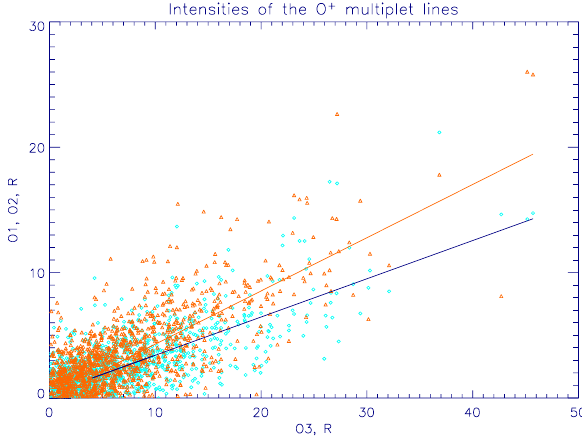
Fig. 7. Plot of I(O + ) vs. N + 1N(0,2) in electron aurora. The bright- 2 nesses are derived as I(O + )=O3/0.357 and I(0,2) = Proxy(0,2)/0.198 . Red triangles – 17 December 2001 points, cyan diamonds – 14 Jan- uary 2002 points. Solid lines show two linear fits to the data: blue for intensities of N + 1N(0,2) between 100R and 400R, orange – 2 for intensities above 400R.